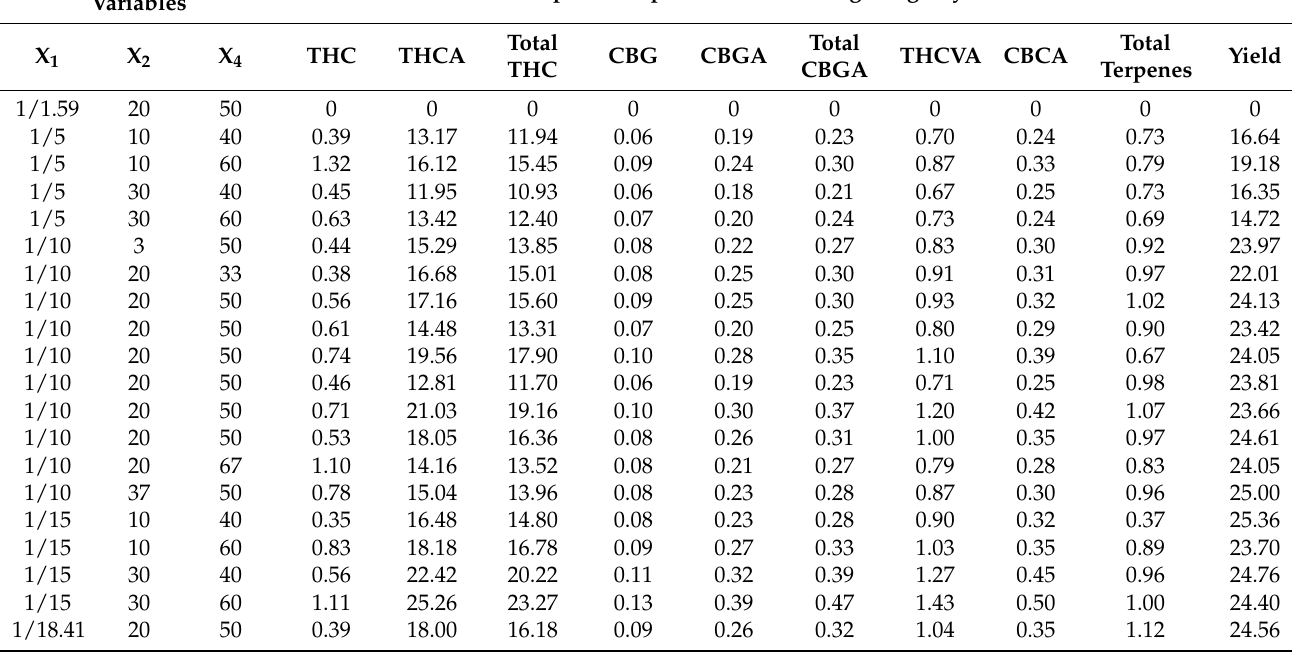
Table 3. Crude cannabis oil yield and concentration of cannabinoids and total terpenes obtained from cryo-ground cannabis subjected to microwave-assisted